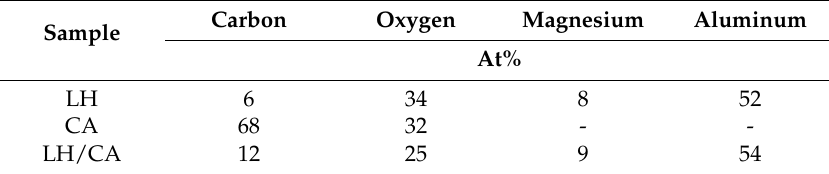
Table 1. Quantitative evaluation of the surface composition of LA and LH-based pigments calculated based on XPS analysis.